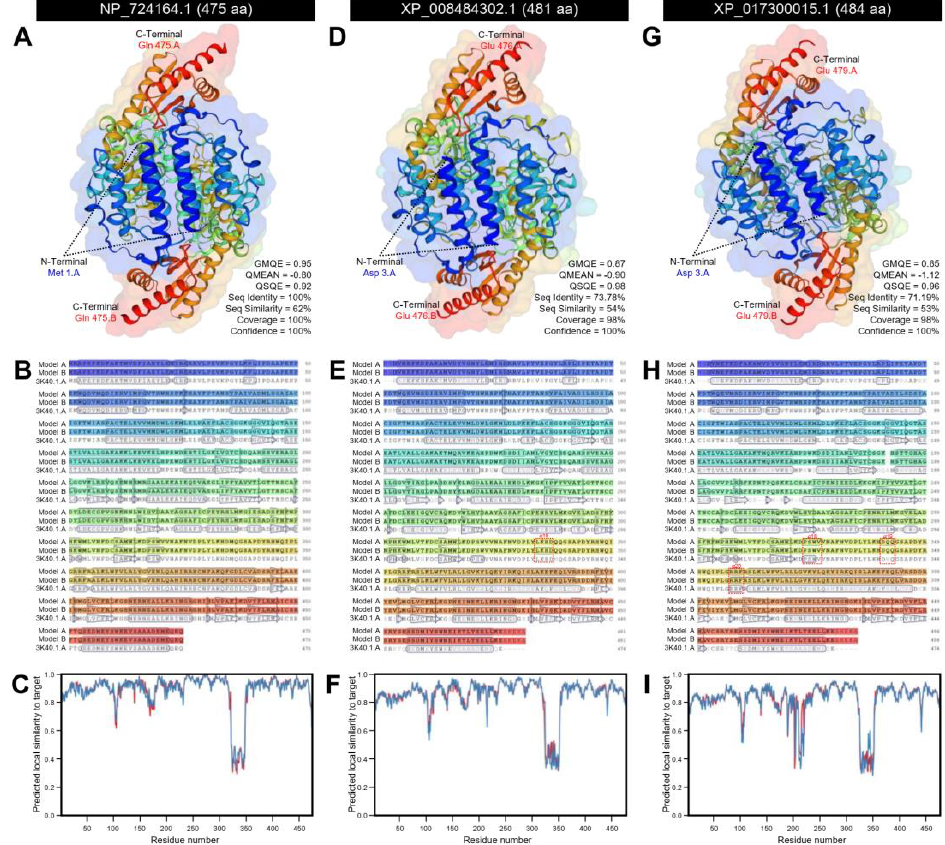
Figure 5. The crystallographic three-dimensional (3D) modeling of aromatic L-amino acid decarboxylase ( DcAADC ) of Diaphorina citri . ( A , D , G ) The predicted three-dimensional (3D) structure model and its associated surface of DmAADC (NP_724164.1), DcAADC -1(XP_008484302.1), and DcAADC -2 (XP_017300015.1), respectively. The tertiary structures were predicted with 100.0% confidence by the single highest scoring template of the crystal structure of Drosophila 3,4- dihydroxyphenylalanine decarboxylase (also known as aromatic L-amino acid decarboxylase; PDB ID 3k40.1.A) and refined to 1.75 Å resolution. Protein chains are colored according to the rainbow color spectrum, from blue (N-terminus) to red (C-terminus). ( B , E , H ) Model–template alignment of DmAADC , DcAADC -1, and DcAADC -2, respectively. AA sequences of each model were aligned with the template (3k40.1.A). Secondary structures are represented by rectangles ( α -helices) and arrows ( β -sheets). Matched sequences are indicated in black. ( C , F , I ) Local quality estimate of the predicted models of DmAADC , DcAADC -1, and DcAADC -2, respectively. All bioinformatics analyses were car- ried out based on recent available data on the “ Diaphorina citri OGS v2.0 proteins” dataset available on Citrus Greening Solutions website (https://citrusgreening.org/organism/Diaphorina_citri/genome, 12 February 2021) and the most recent available data in GenBank, the national center for biotechnology information website (NCBI, http://www.ncbi.nlm.nih.gov/gene/, 12 February 2021). The 3D struc- ture was created using the SWISS-MODEL server (https://swissmodel.expasy.org/, 12 February 2021) and visualized with the UCSF-Chimera package (version 1.15) (https://www.cgl.ucsf.edu/chimera/, 12 February 2021). GMQE: Global model quality estimation and QSQE: Quaternary structure quality